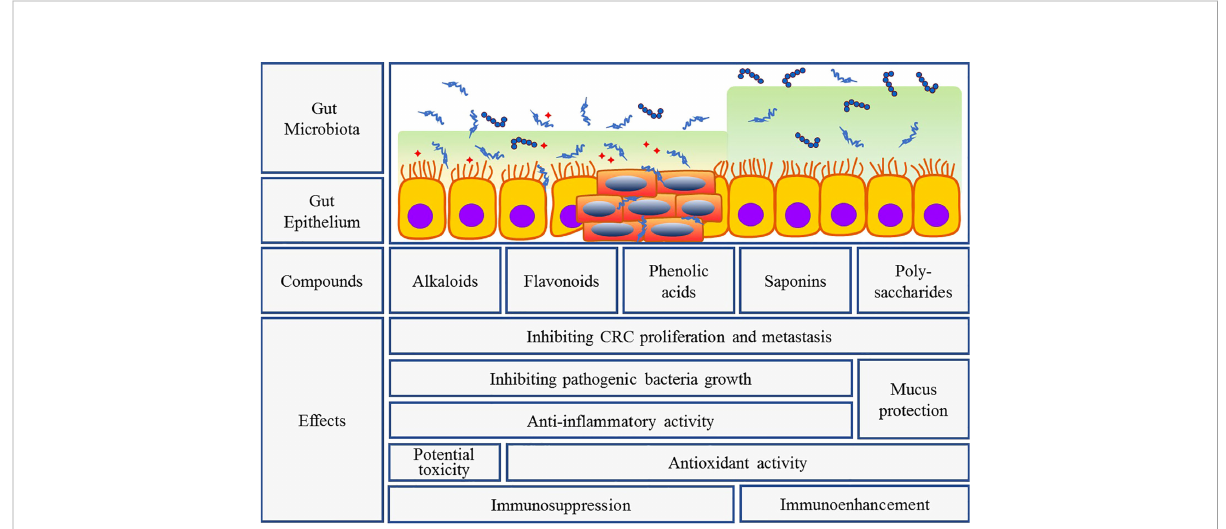
FIGURE 3 Intervention of herbal bioactive components on gut bacteria and CRC. Interaction between herbal medicine and gut microbiota can fi ght tumor growth and prevent tumorigenesis through several mechanisms: (1) inhibiting pathogenic bacteria overgrowth and promoting probiotics growth; (2) anti-in fl ammatory and antioxidant activities as well as intestinal mucosal protection and immune regulation; (3) direct anti-tumor activity. But different components exert their respective